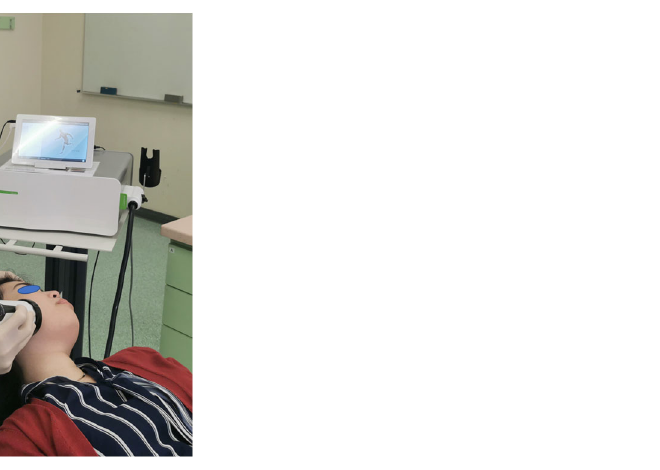
Figure 3. ESWT shows promising results for the treatment of MTrPs of masseter muscles in patients with myogenous TMD.